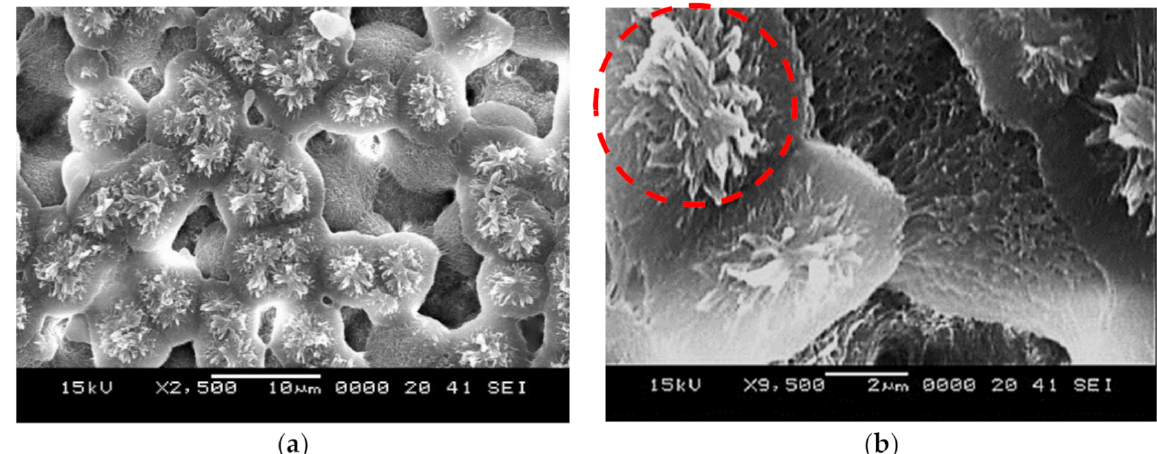
Figure 1. SEM images of crystallized surface: ( a ) micro size spherules, which represent the crystallized structures. Increasing acetone concentration or immersion duration, micro-size spherules become congested while lowering surface contact angle considerably and ( b ) fibrils on spherules (in the red dotted circle). Fibrils are formed from the crystallized sites and they create the Lotus effect reducing contact angle hysteresis.